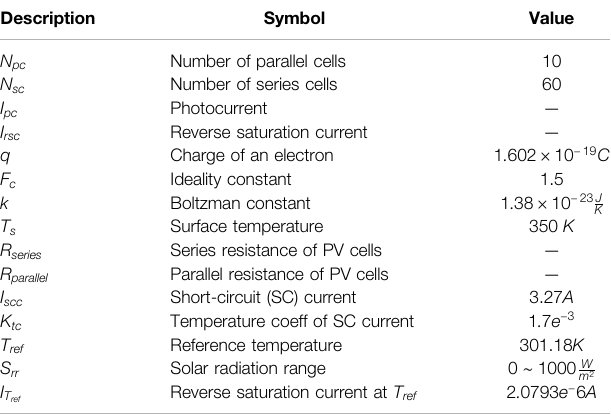
TABLE 1 | Model parameter for PV